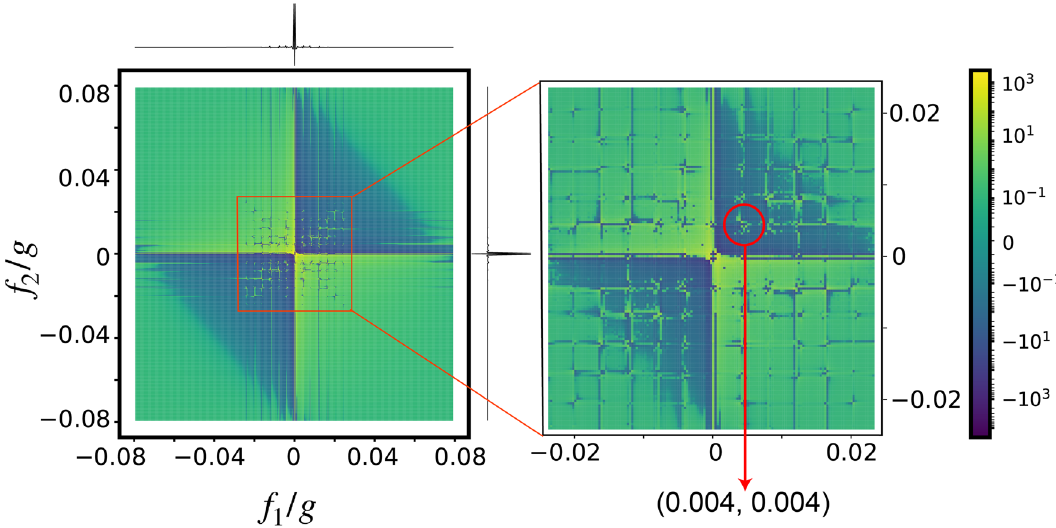
Figure 5. PrePSy applied on a single NV placed in a cavity with an environment of five other NVs. Parameters 10 g and (cid:31) 0.01 g , ξ 0.001 g are chosen as (cid:31) = = =